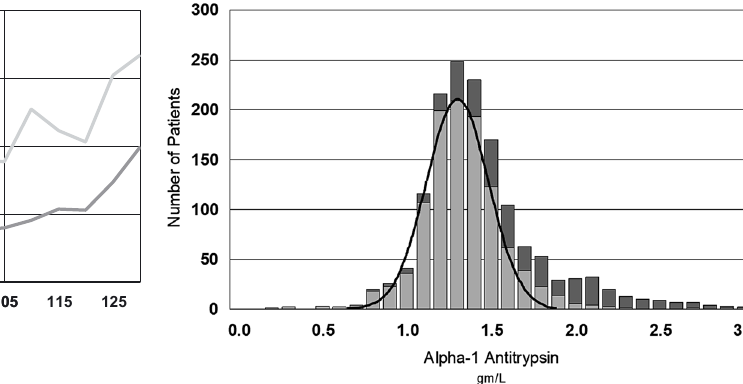
Figure 3: Gaussian distribution of alpha-1-antitrypsin (A1AT) levels in 1,125 patients with normal C-reactive protein (CRP) ( ≤ 5 mg/L, light bars) compared to higher levels of A1AT in 475 patients with raised CRP (dark